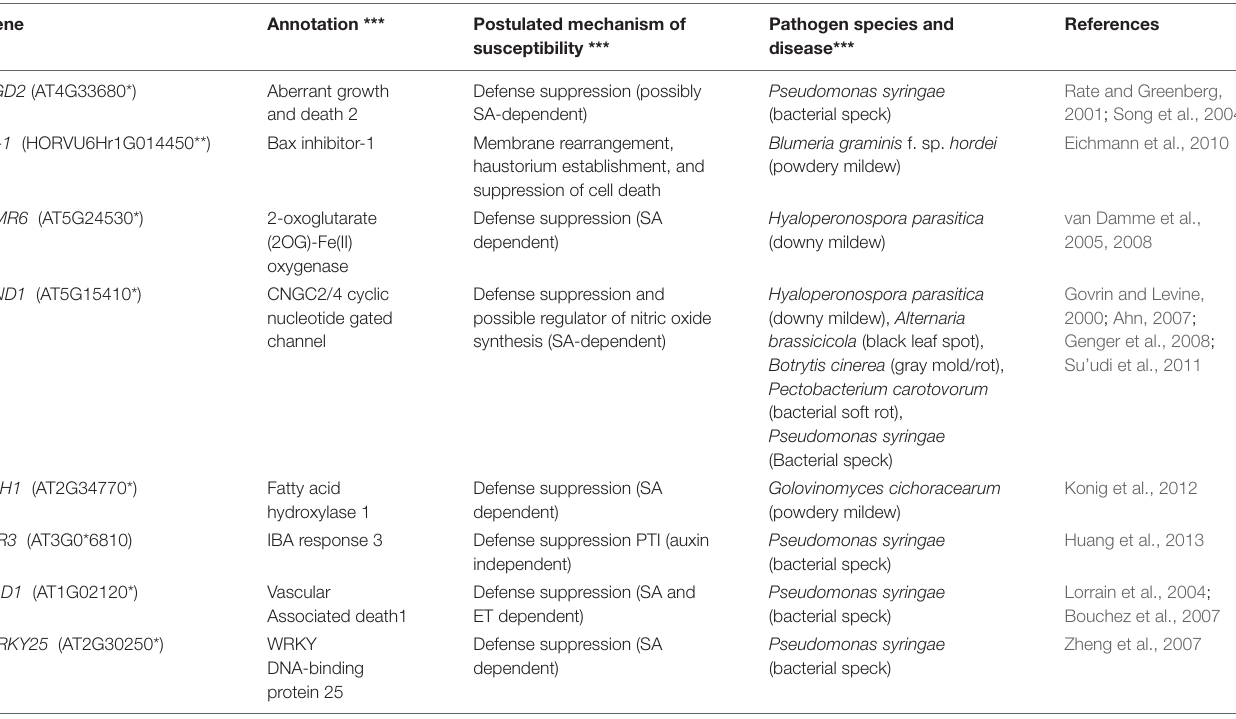
TABLE 2 | List of S genes explored through the gene expression